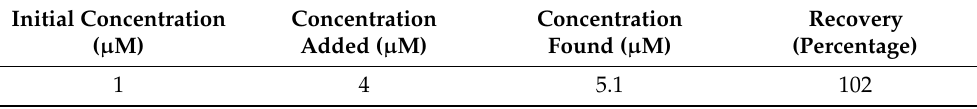
Figure 5. Bar graph depicting the stability of the modified electrode DNA probe/AgNPs/PBGS for TDNA on the 7th, 14th, 21st, and 30th day in 10 mM methylene blue in 0.1MKCl at 50 mV s − 1 in the potential range from − 1 V to +1 V. Table 1. Recovery test of constructed biosensor of ZIKV.